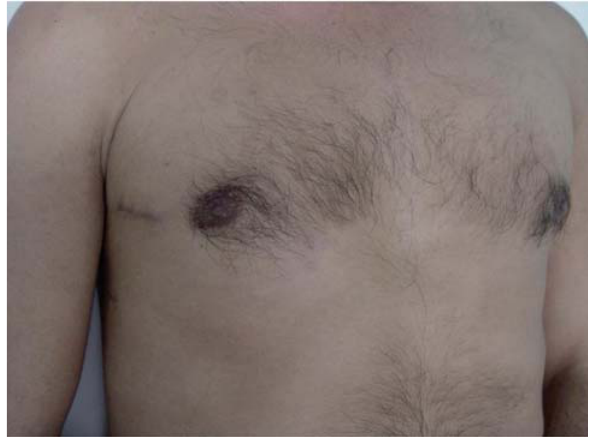
Fig. 3 - Cicatriz do acesso videoassistido para troca valvar mitral no pós-operatório